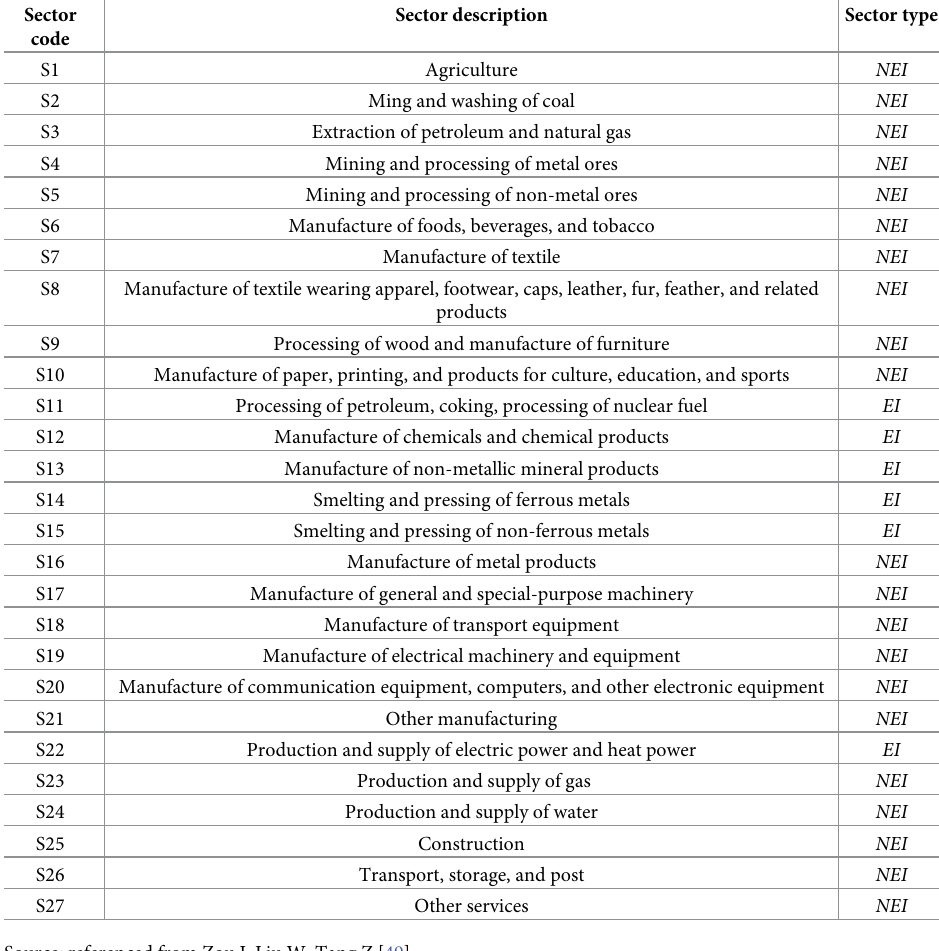
Table 1. Sector code and description within the Chinese